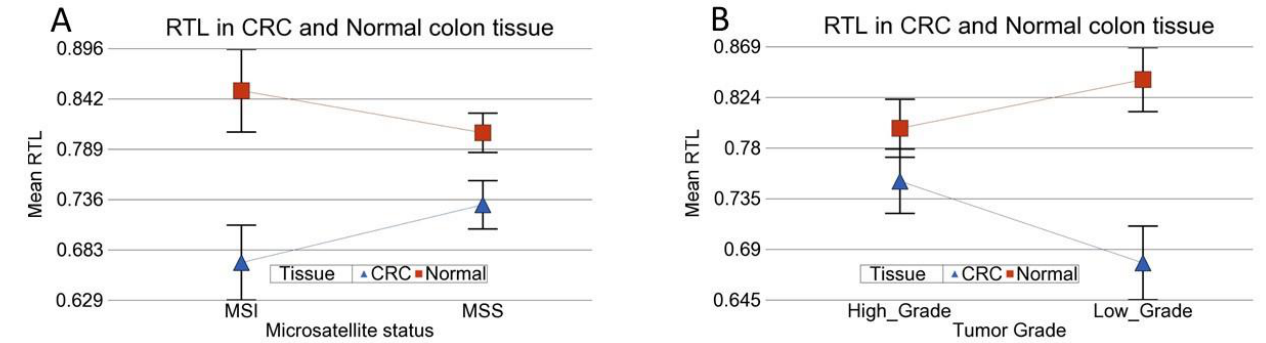
Figure 3. Comparison of RTL in CRC tissue (in blue) and corresponding normal tissue (in red) by MSI status ( A ) and by tumor grade ( B ). RTL shortening in CRC tissue was greater in MSI tumors, as well as in low-grade tumors.